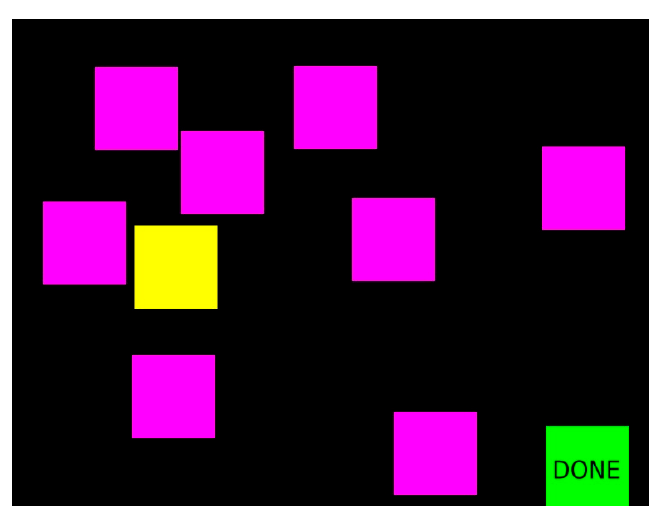
Figure 2. Corsi span sample.